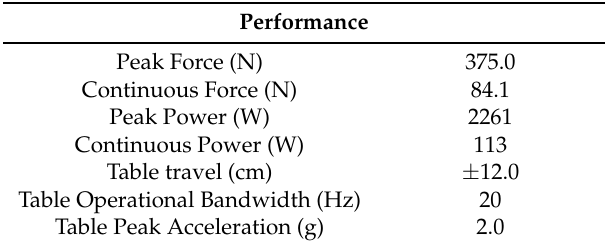
Table 1. Performance properties of the employed shaking table.